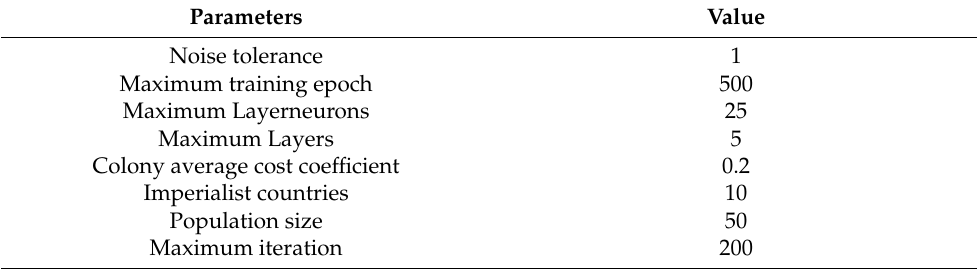
Figure 11. The sensitivity analysis results of the proposed model. Table 7. The parameters with the optimal values by sensitive analysis.